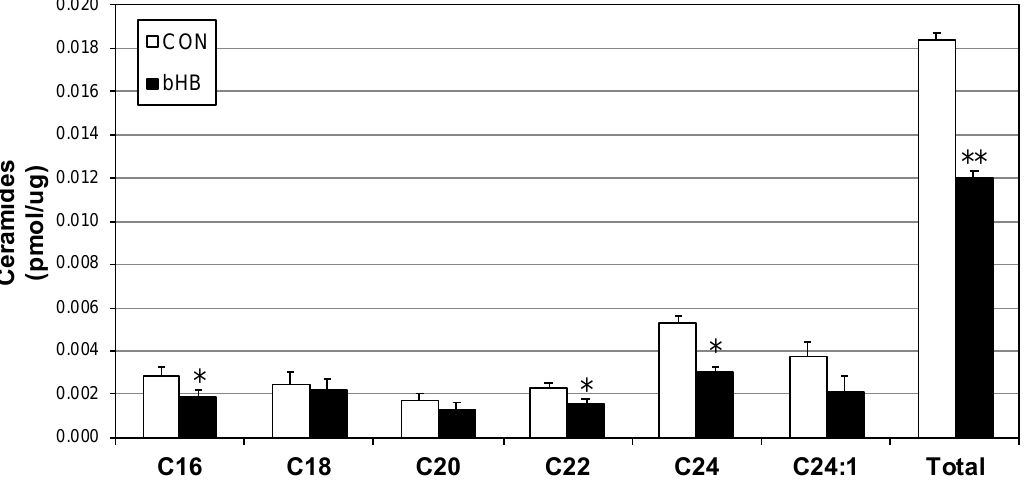
Figure 4. β -Hydroxybutyrate reduces select ceramide species. Following treatment with vehicle (PBS; CON) or with β -Hydroxybutyrate ( β -HB; 5 mM) for 24 h, lipids were isolated from C2C12 myotubes